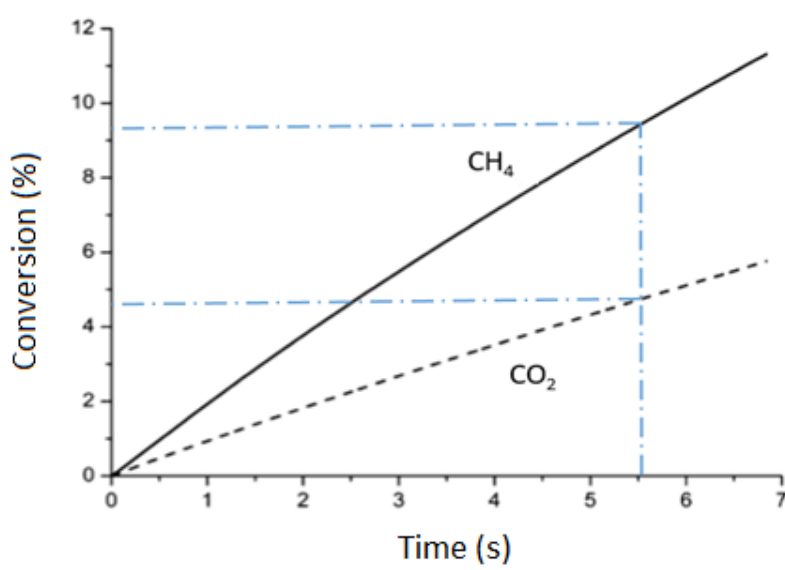
Figure 4. Calculated CH 4 and CO 2 conversion as a function of residence time in a non-packed DBD reactor, adopted from modelling. Adopted with permission from ref. [46]. Copyright 2018 American Chemical Society.